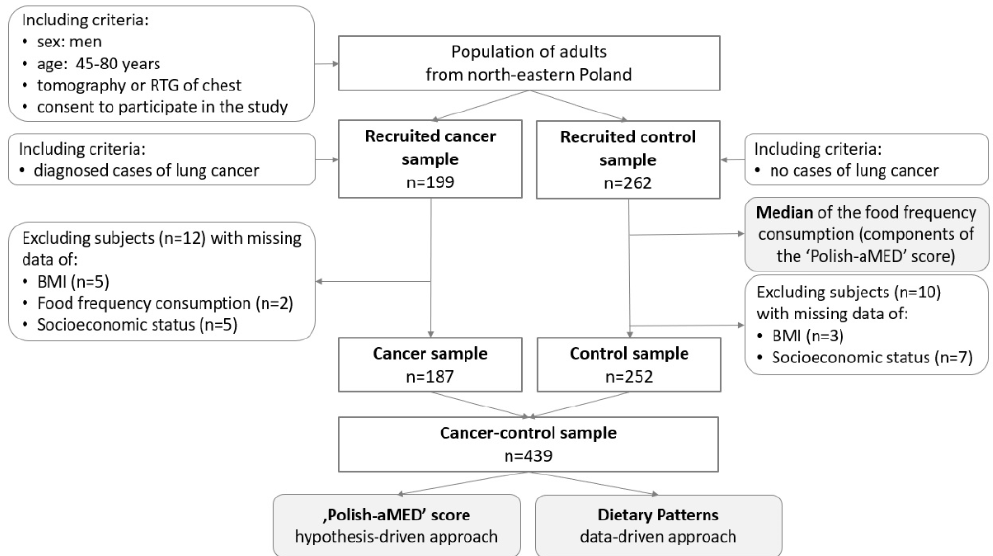
Figure 2. Flow chart of the sample collection and study design. Notes: RTG: digital X-ray examination; BMI: body mass index; Polish-aMED: Polish-adapted Mediterranean diet score . BMI: body mass index; Polish-aMED: Polish-adapted Mediterranean diet